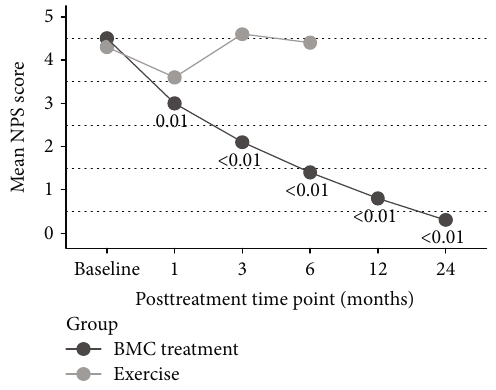
Figure 4: NPS scores before and after BMC treatment. Displayed p values re fl ect comparison to baseline. Exercise N : 9, 10, 5; BMC treatment N : 23, 22, 24, 23, 23, 17.